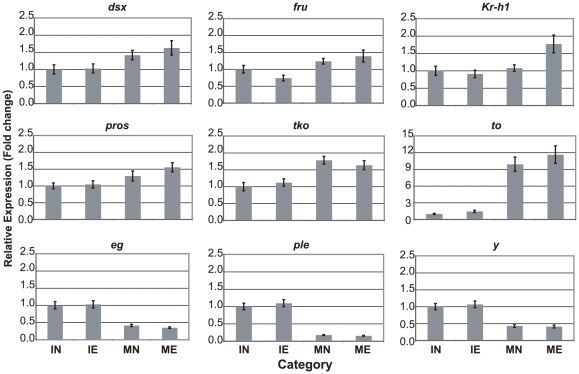
Expression levels of individual genes for each age/experience category.Relative expression levels standardized to “IN” category are reported, as well as corresponding standard errors. Only genes with significant differences in expression due to age are displayed.